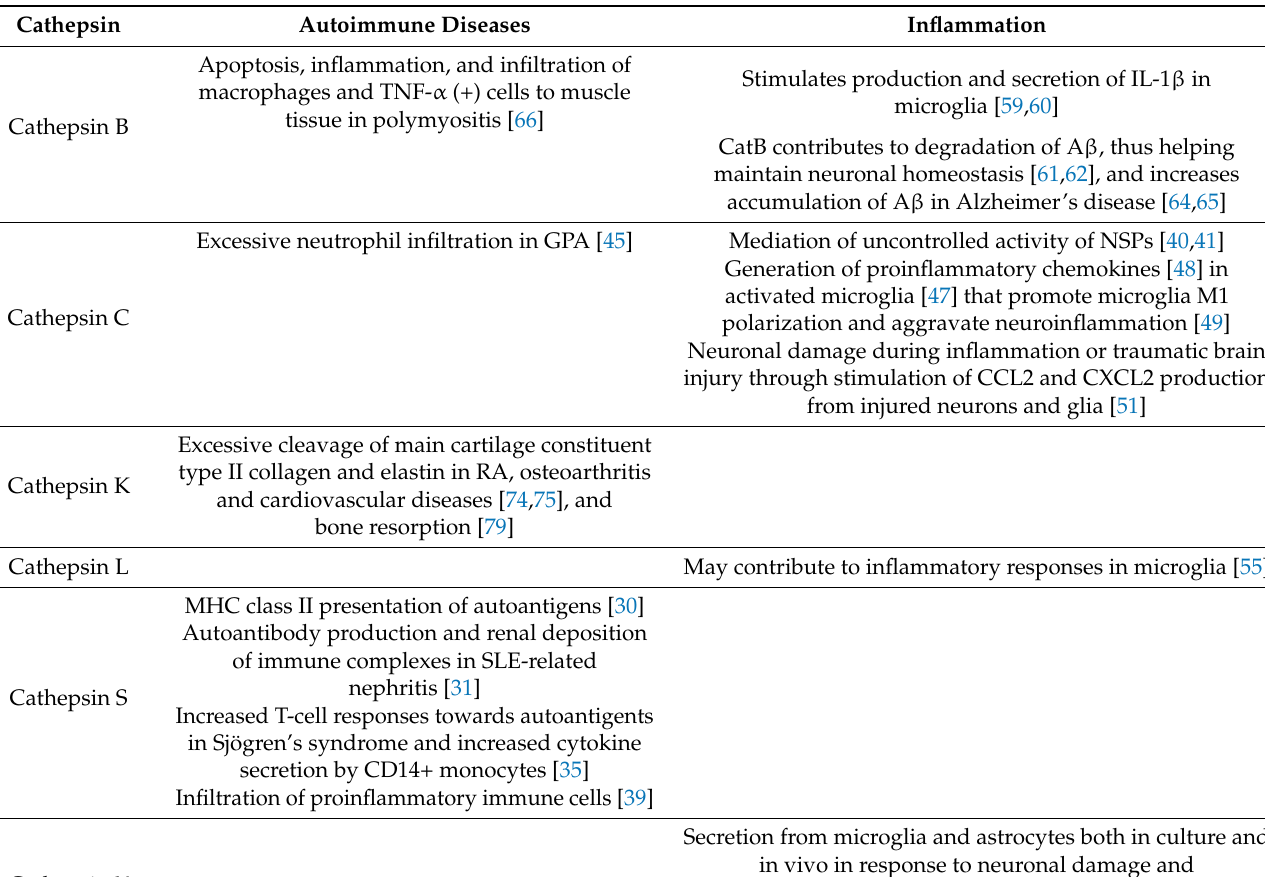
Table 1. The role of cysteine cathepsins in inflammation and autoimmune